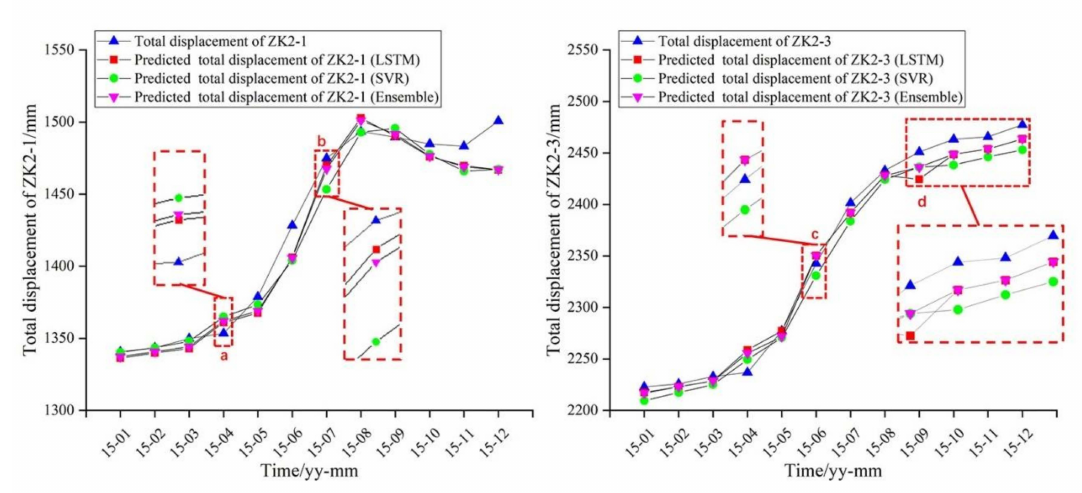
Figure 13. The curves of the relationship between observed and predicted displacement.